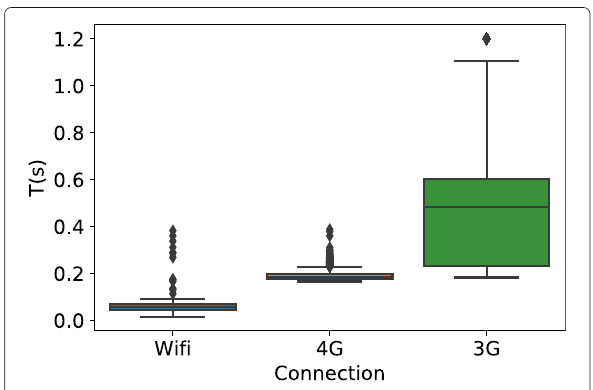
Fig. 8 Specification of the Latency Obtained in the Final User Entity for 3G, 4G and WiFi Connections